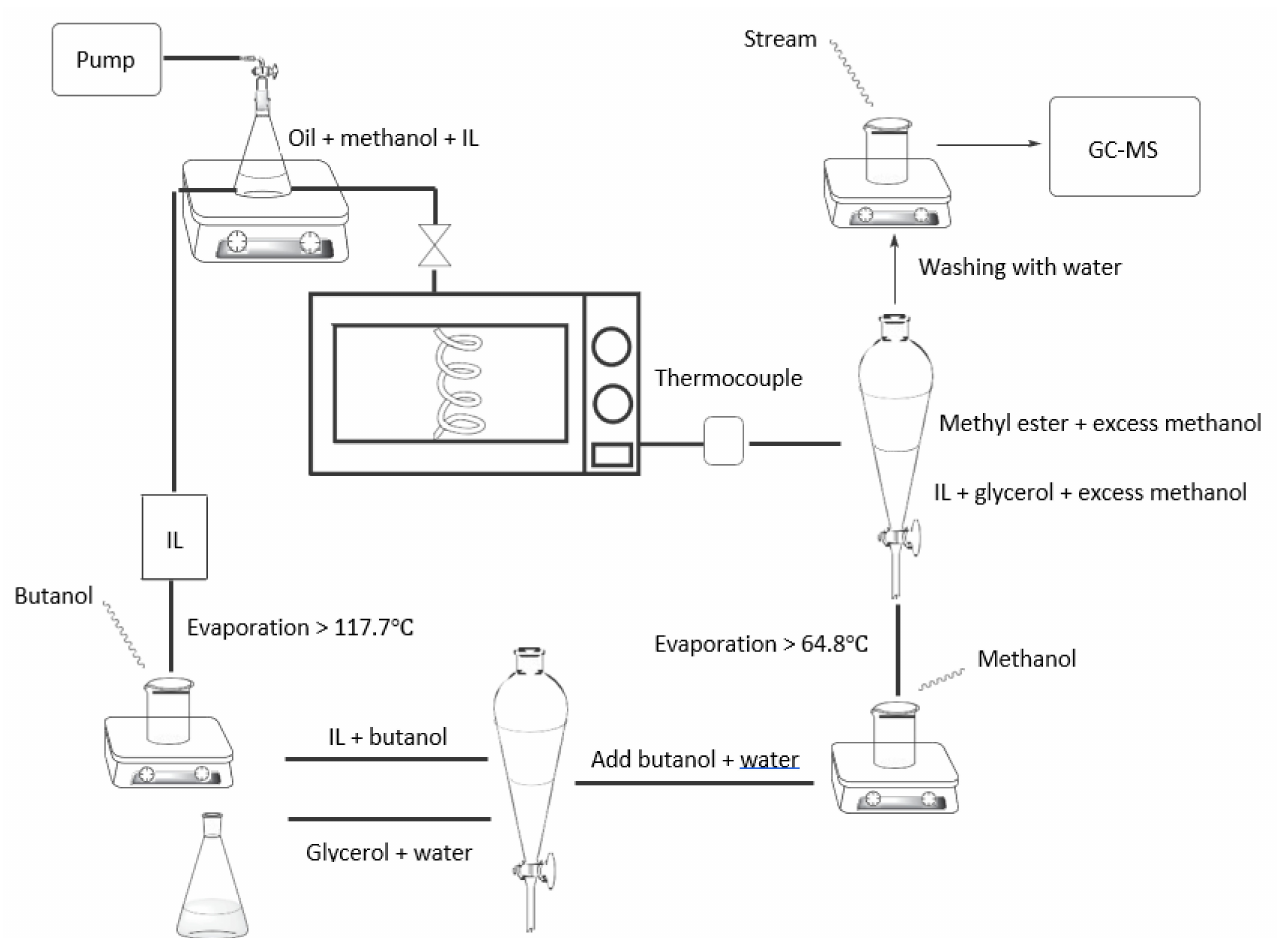
Figure 5. Biodiesel production for microwave and ionic approach. Reproduced with permission from Ren. Energy 2020 , 925–936. Copyright (2020) Elsevier